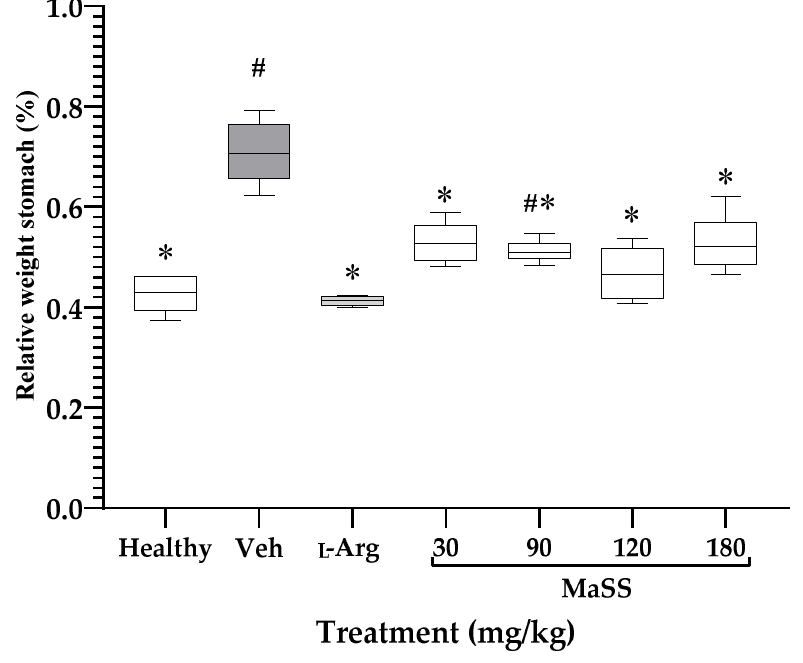
Figure 2. Effect of MaSS at different doses on relative stomach weight of rats with ethanol-induced gastric lesions. Healthy = rat without gastric lesions, Veh = rat with gastric ulcers, L -Arg = L -arginine (300 mg/kg), MaSS = mixture of kaempferol 3- O -sophoroside and kaempferol 3- O -sambubioside. Kruskal-Wallis with a post-test of Dunns’s multiple comparisons (n = 5, x ± ED, # p < 0.05 when groups are compared with healthy group; * p < 0.05 compared with Veh group).